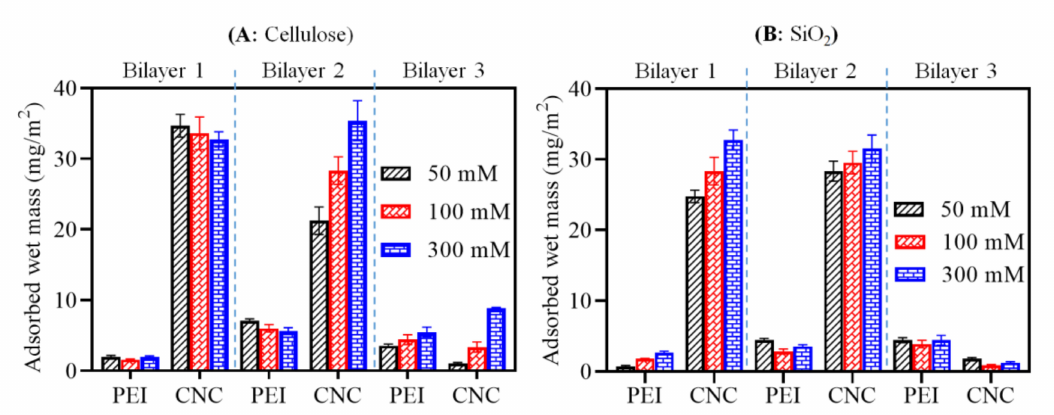
Figure 3. Comparison of adsorbed mass (wet) for the adsorption of PEI and CNCs on the surfaces cellulose ( A ) and SiO 2 ( B ) as a function of ionic strength of PEI solution.